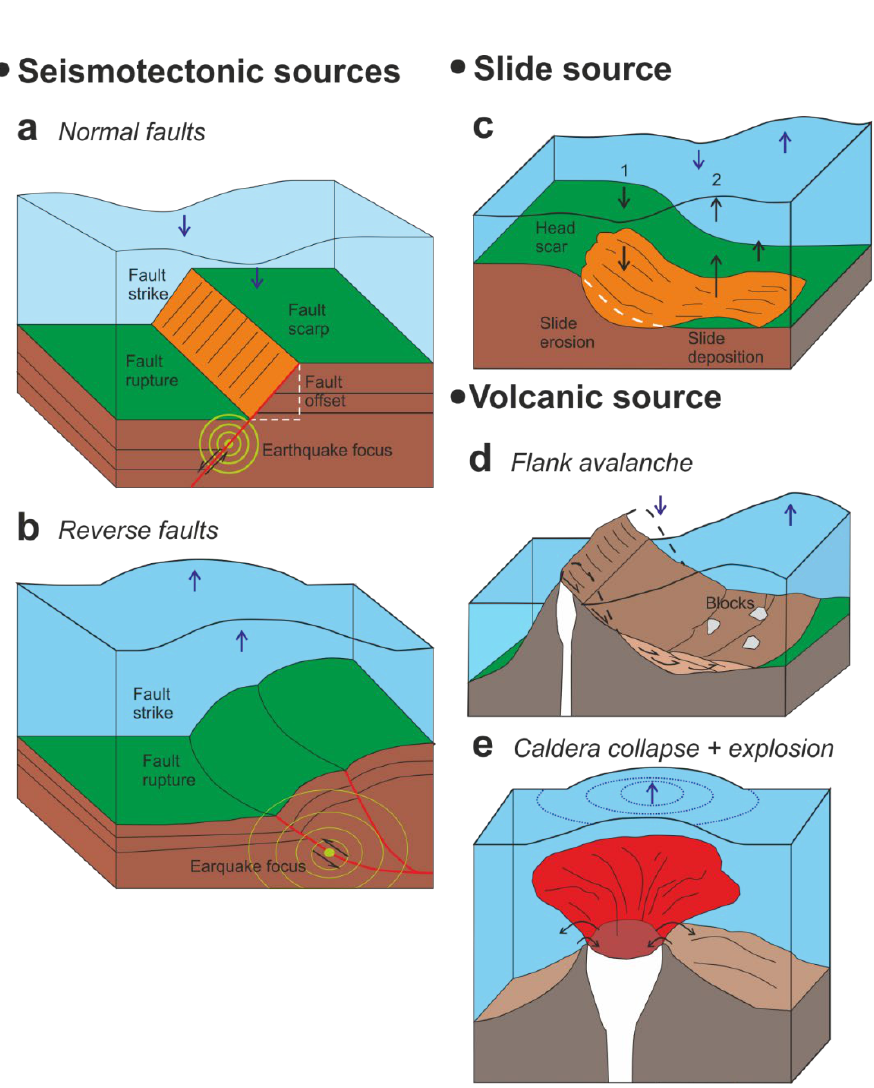
Figure 8. Sketch of the main tsunamigenic sources of geological origin: ( a ) Normal fault activity; ( b ) reverse fault activity; ( c ) submarine landslide. Numbers 1 and 2 refer to the time-sequenced development of the initial tsunami shape in the water surface; ( d ) collapse flanks of volcanoes; ( e ) volcanic explosion related to eruptions and caldera collapses.